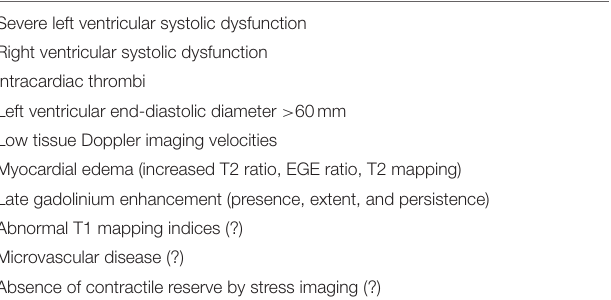
TABLE 3 | Imaging predictors of poor outcome in peripartum